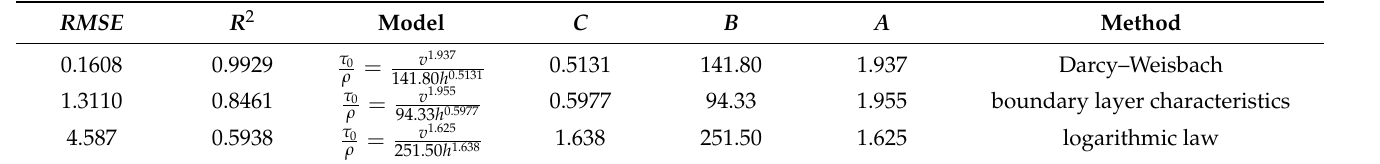
Table 7. Calibration results of three–parameter resistance model using three different methods. RMSE R 2